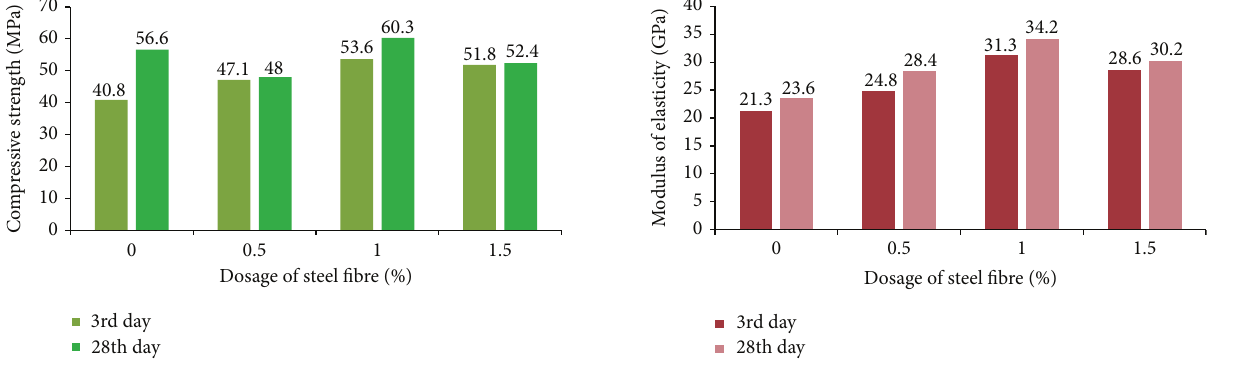
Figure 7: Compressive strength of various volume fractions of steel fibre reinforced geopolymer concrete mixes.